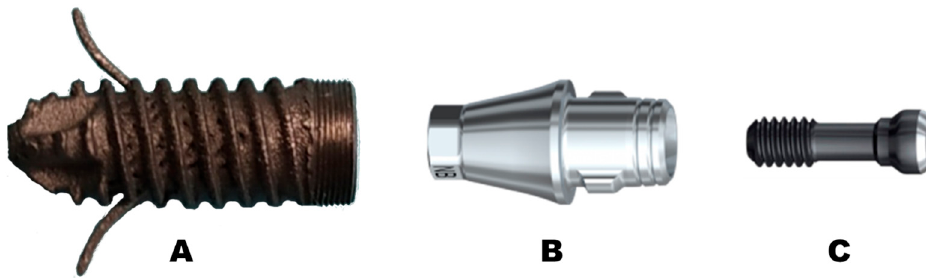
Figure 8. ( A ) The dental implant, ( B ) universal conical base connection, and ( C ) securing